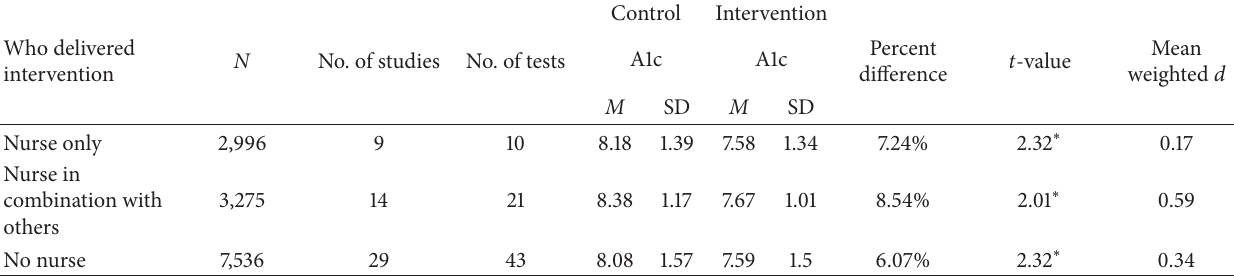
Table 5: Mean Outcome A1c levels for control and intervention groups, by type of professional who delivered intervention. Control